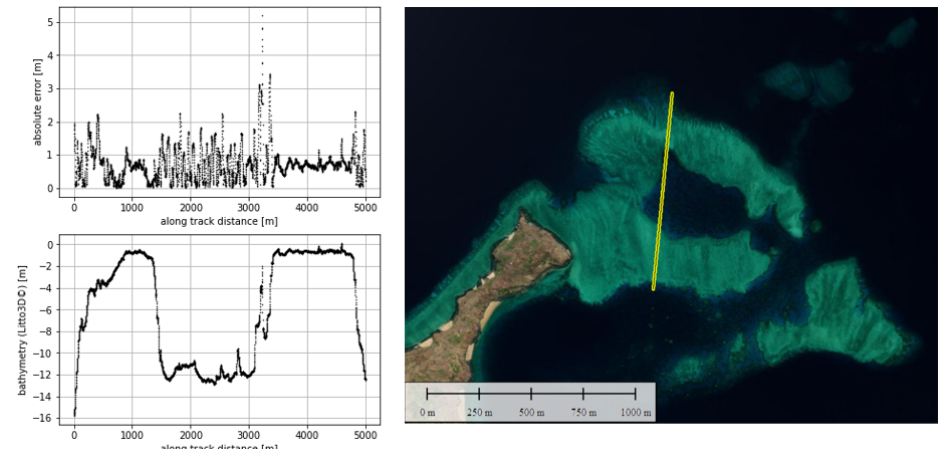
Figure A2. Evolution of the absolute error with depth on a transect along the ICESat-2 ground track.